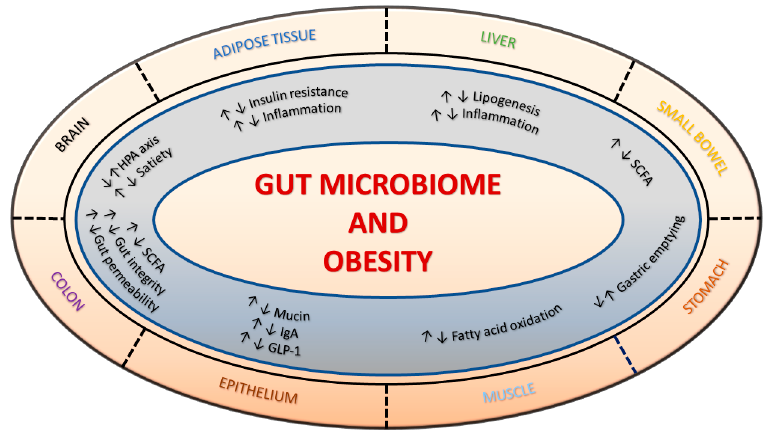
Figure 1. Influence of the gut microbiome on obesity. The figure depicts the bidirectional influence of gut health on obesity via alterations in the microbiome. SCFA: short ‐ chain fatty acid; IgA: immunoglobulin A; GLP ‐ 1: glucagon ‐ like peptide ‐ 1; HPA: hypothalamic–pituitary–adrenal (axis).